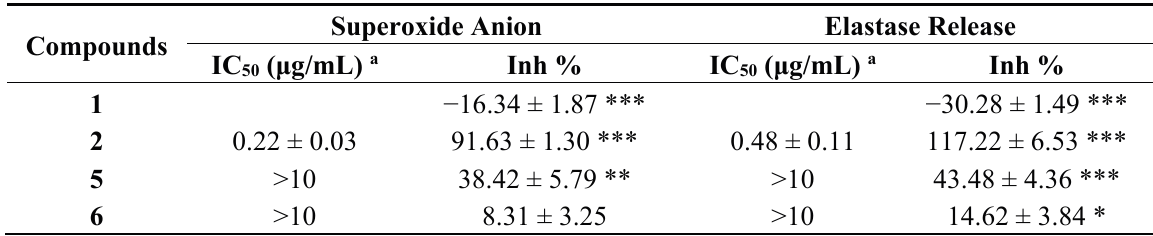
Percentage of inhibition (Inh %) at 10 μ M concentration. Results are presented as mean ± S.E.M. (the standard error of mean) ( n = 3 or 4). * p < 0.05, ** p < 0.01, *** p < 0.001 compared with the control